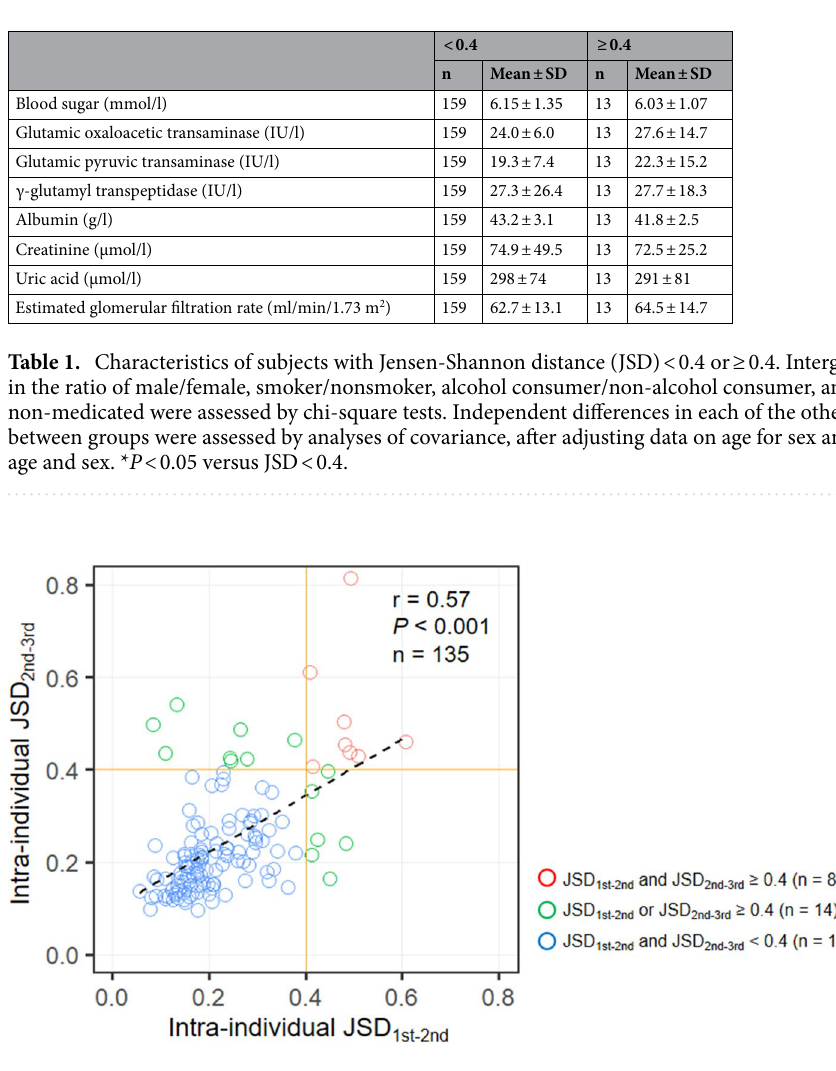
Figure 3. Association between intra-individual Jensen-Shannon distance from the first to the second (JSD 1st–2nd ) and from the second to the third (JSD 2nd–3rd ) fecal collections with respect to yearly changes in the gut microbiota. Spearman’s rank correlation analysis assessed the association between the JSDs during two